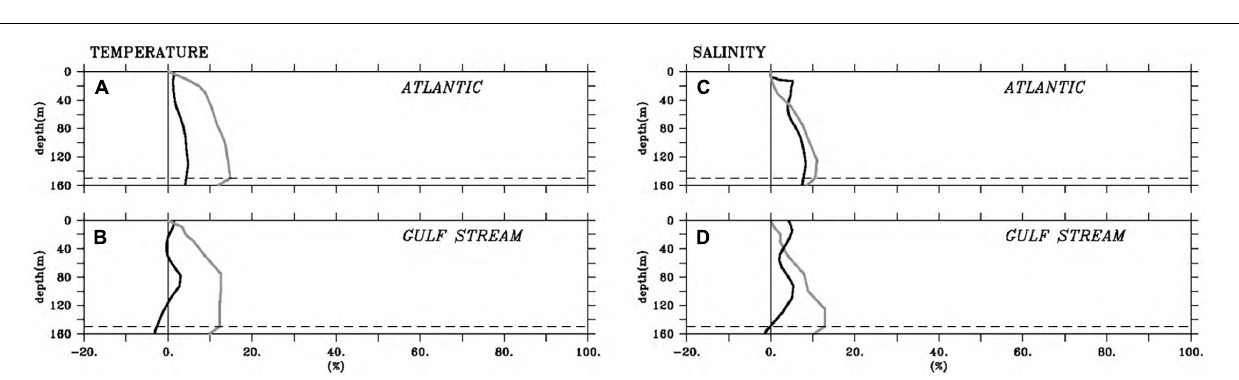
FIGURE 7 | Same as Figure 5 , but for the DRIFTER experiment as compared with the BACKBONE experiment from MOI (black), and the CLS (gray) systems in the upper 160 m. The horizontal dashed line indicates the maximum depth of the synthetic drifter